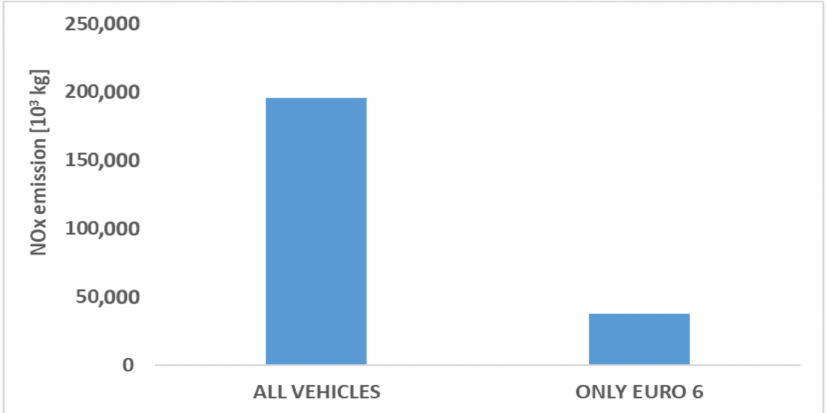
Figure 17. Comparison of NO X emissions from all vehicles and Euro 6 vehicles only.